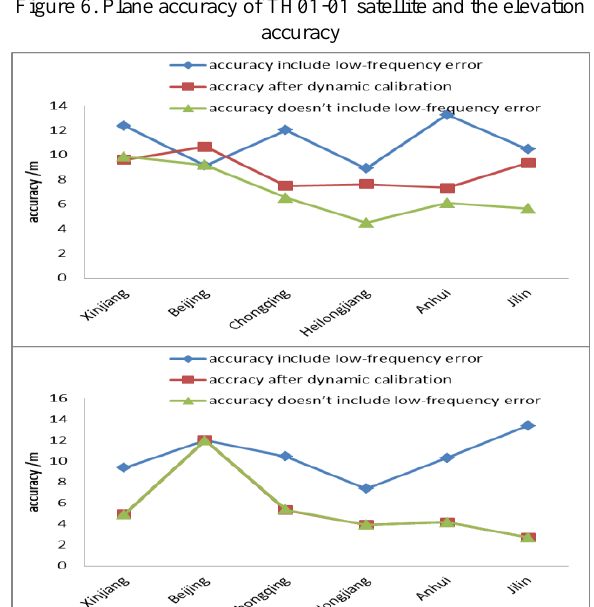
Figure 7. Plane accuracy of TH01-02 satellite and the elevation